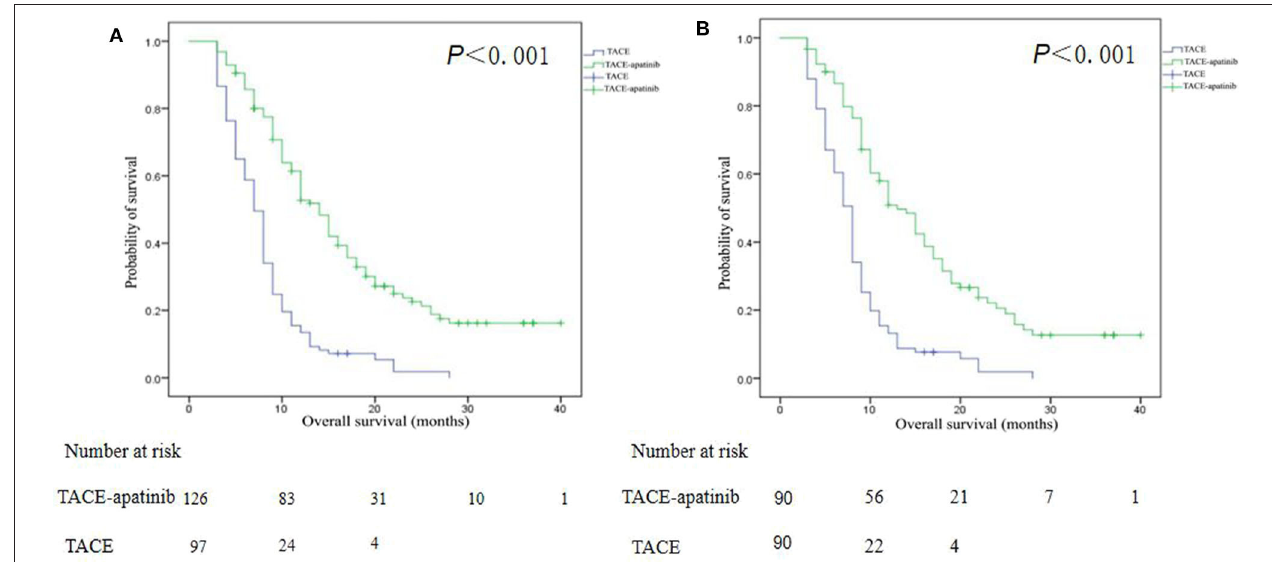
FIGURE 4 | Kaplan–Meier curves of overall survival for patients with advanced hepatocellular carcinoma who received the treatment of transarterial chemoembolization (TACE)–apatinib or TACE alone before (A) and after (B) propensity score matching.